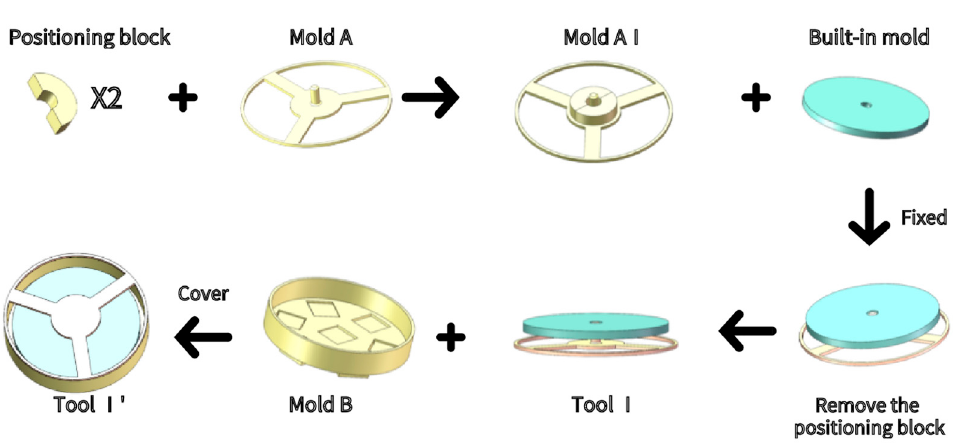
Figure 9. SAM mold Figure 9. SAM mold preparation. Figure 9. SAM mold preparation.